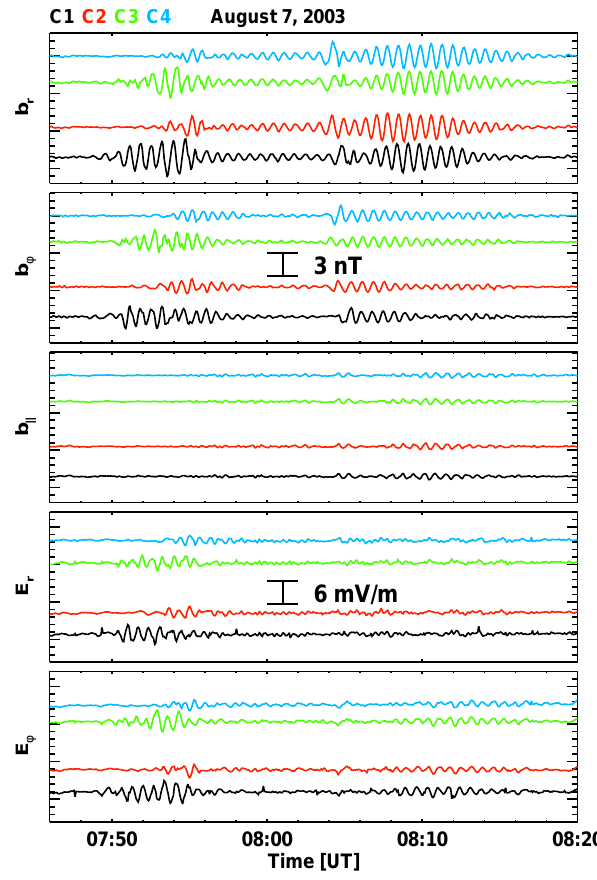
Fig. 3. FGM and EFW measurements for the four Cluster space- craft (C1: black, C2: red, C3, green, C4: blue), transformed into a Mean-Field-Aligned coordinate